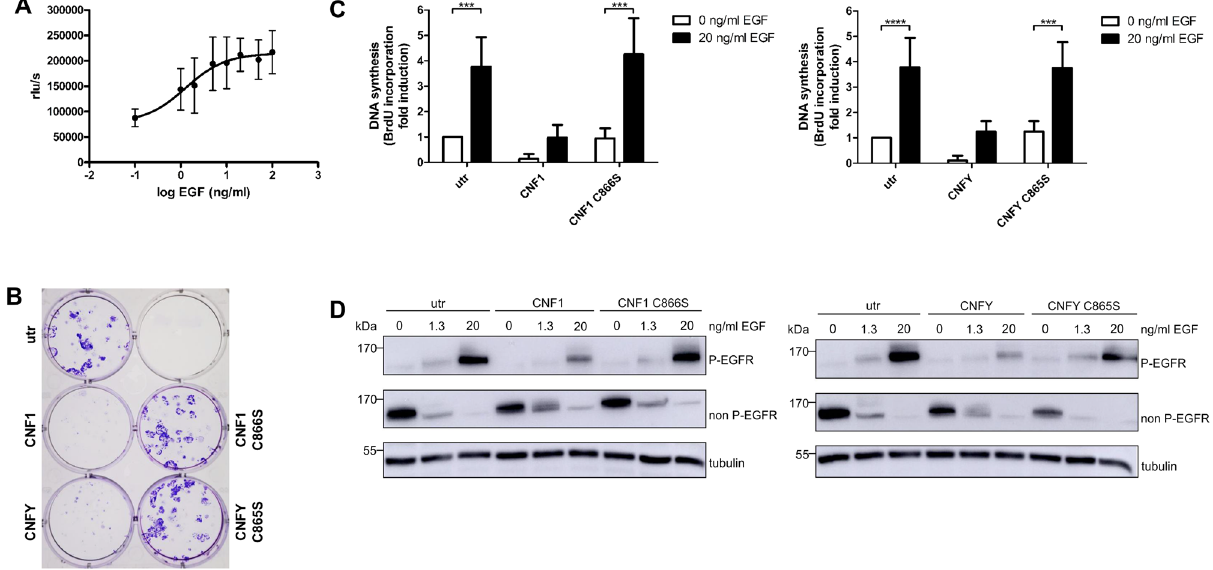
Figure 4. CNF1 and CNFY inhibit the EGF-dependent proliferation of MCF10A cells. ( A ) Dose versus response curve of BrdU incorporation after EGF stimulation. MCF10A cells were serum starved for 24 h and then stimulated with different EGF concentrations (0, 1, 2, 5, 10, 20, 50, 100 ng/ml) for 24 h. BrdU incorporation was measured as relative light units per seconds (rlu/s) and the EGF response was calculated using non- linear regression analysis. Data of three independent experiments are shown. EC 50 = 1.3 ng/ml. Saturation of the stimulation was reached at 20 ng/ml EGF. ( B ) MCF10A cells were intoxicated with CNF1, CNFY or their inactive mutants for 2 days. After serum starvation for three h the cells were stimulated with 20 ng/ml EGF in medium containing 1% serum for eight days. Then, the colonies were fixed and stained with crystal violet (representative of n = 3). ( C ) MCF10A cells were treated with CNF1, CNFY or their inactive mutants for 48 h under serum starvation and were then stimulated with 0 or 20 ng/ml EGF for 24 h in the presence of the toxins, respectively. BrdU incorporation was measured and normalized as fold induction of the non- intoxicated unstimulated control. Data of three independent experiments were quantified and analyzed using two-way ANOVA. ***p < 0.001, ****p < 0.0001. ( D ) Western Blot analysis of EGFR phosphorylation after CNF intoxication. MCF10A cells were treated with CNF1, CNFY or their inactive mutants for 48 h under